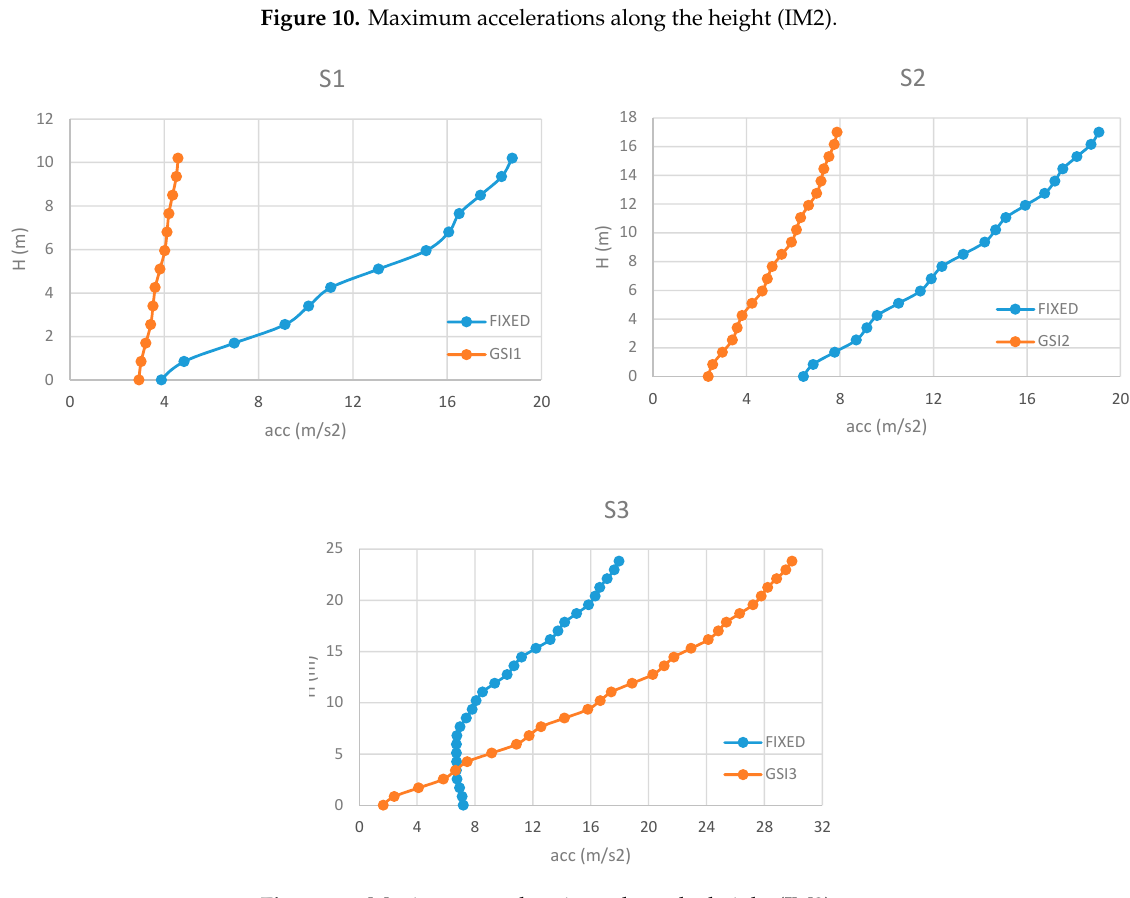
Figure 11. Maximum accelerations along the height (IM3).